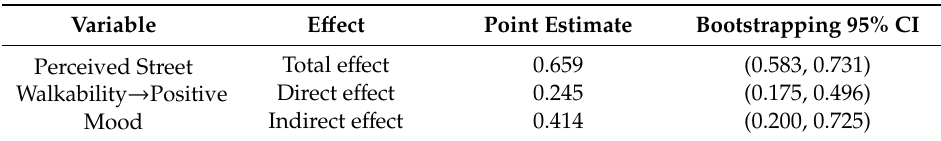
Table 6. Model e ff ect